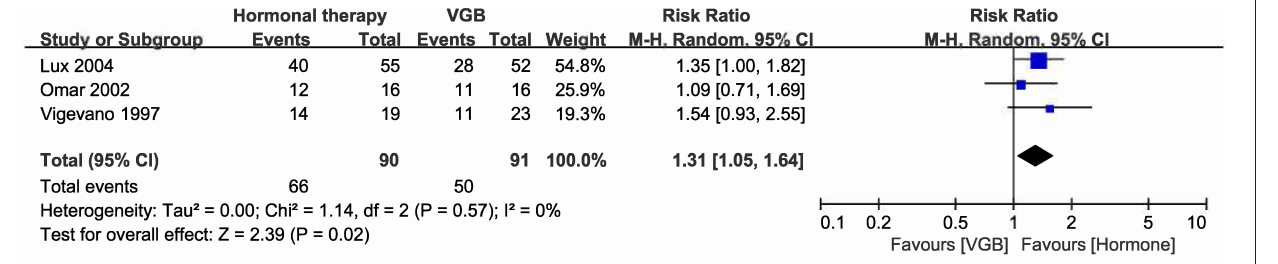
ACTH group: from 47.7 to 49.9). AEs were reported in 31.6% and 42.1% of patients in the combination therapy group and ACTH group, respectively, but were not significantly different between the two